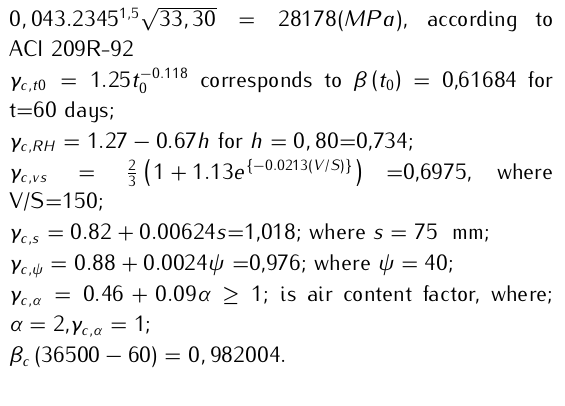
Figure 3. Values of normal stresses in upper fiber of concrete plate σ up t ) in time t ∞ when loading is applied in time c (